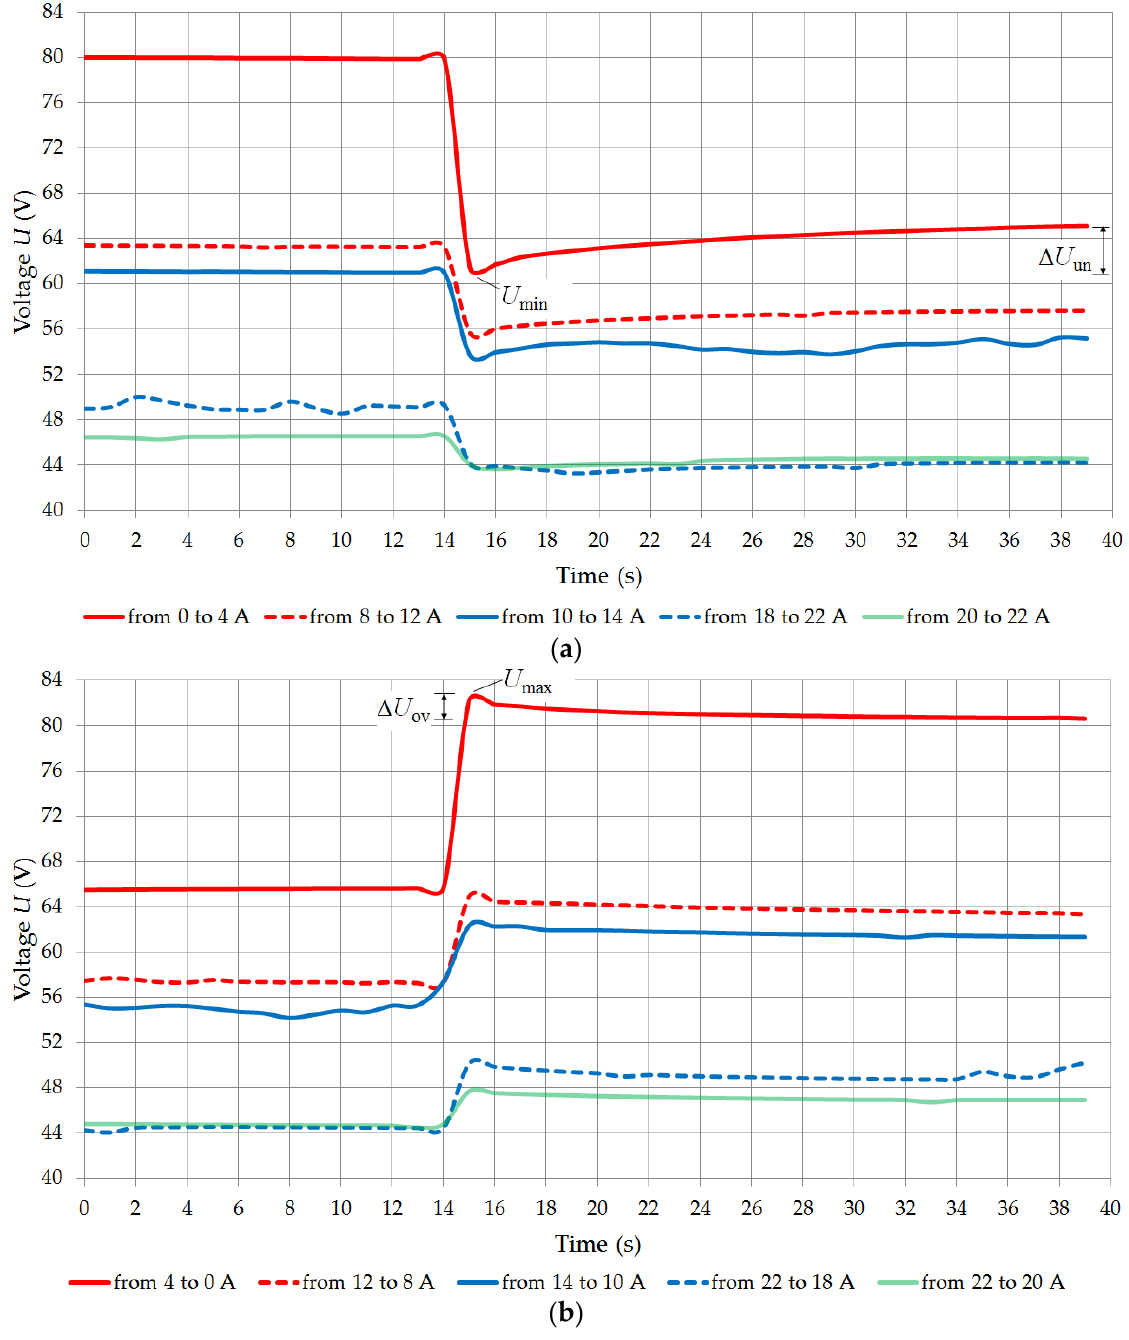
Figure 12. Diagrams of changes in PEMFC output voltage U PEMFC with a change in the load current: ( а ) load increase; ( b ) load decrease.